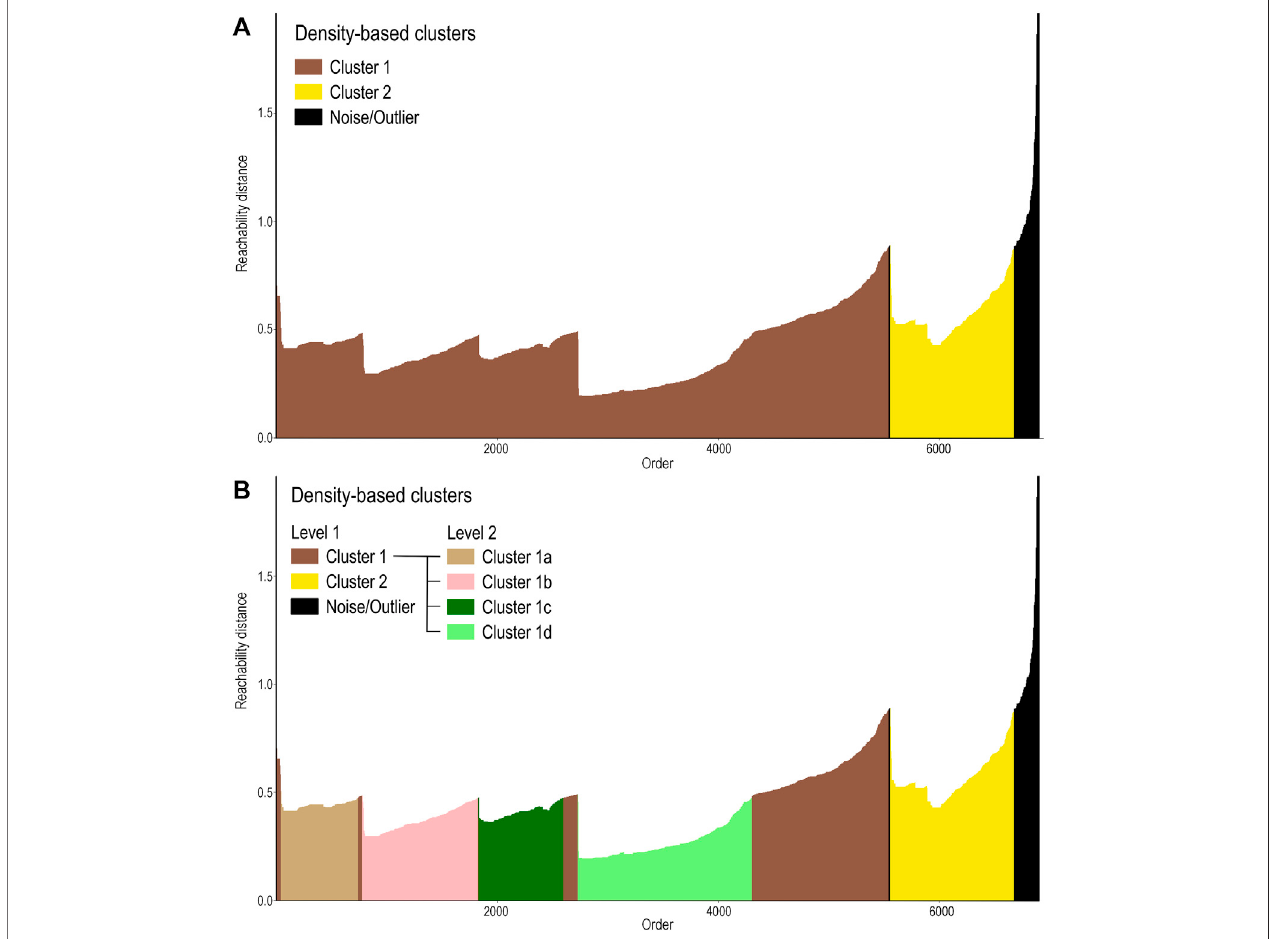
FIGURE13| Reachabilityplotofahierarchicalclusteringwith (A) twomainclusters(reachabilitydistance=0.88)andnoise;and (B) clustersatdetailedhierarchical level (reachability distance = 0.475).